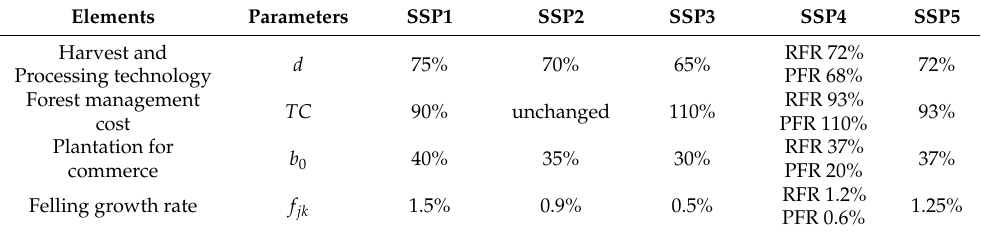
Table 1. Narratives for shared socioeconomic pathway scenarios in forest